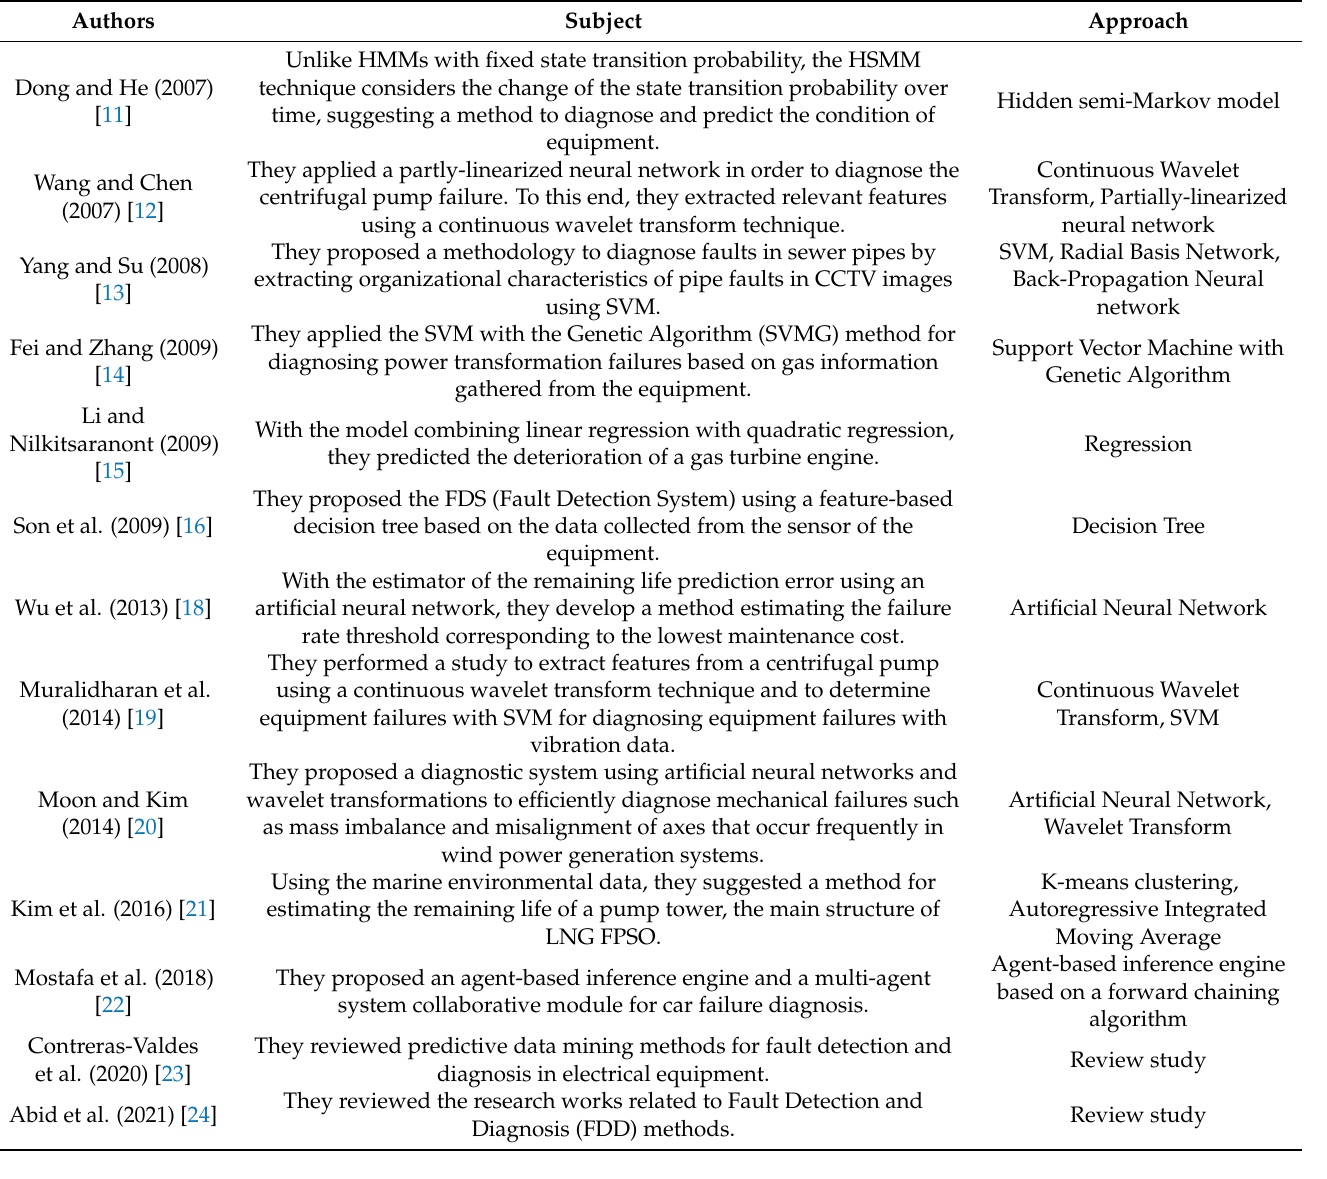
Table 3. Previous works on failure